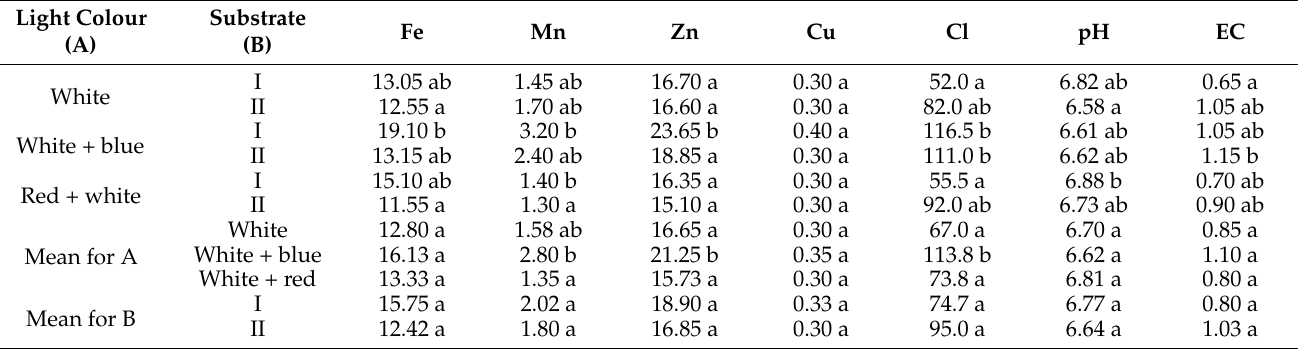
Table 2. Micronutrients content (mg · dm − 3 ) in substrate, pH and EC (mS · cm − 1 ) depending on light colour and substrate.